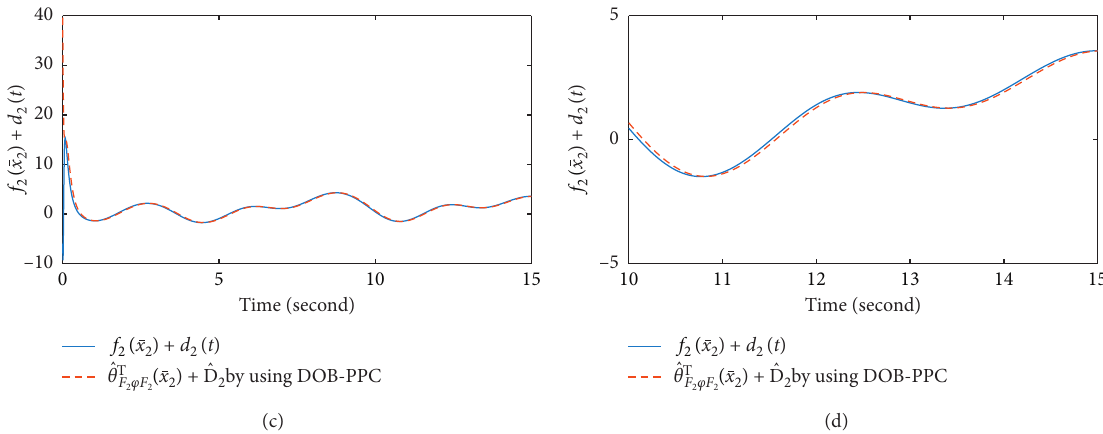
( x ) + d ( t ) by using DOB-PPC in time period (a) [0, 15s]; (b) [10s, 15s]; estimation of f 1 1 1